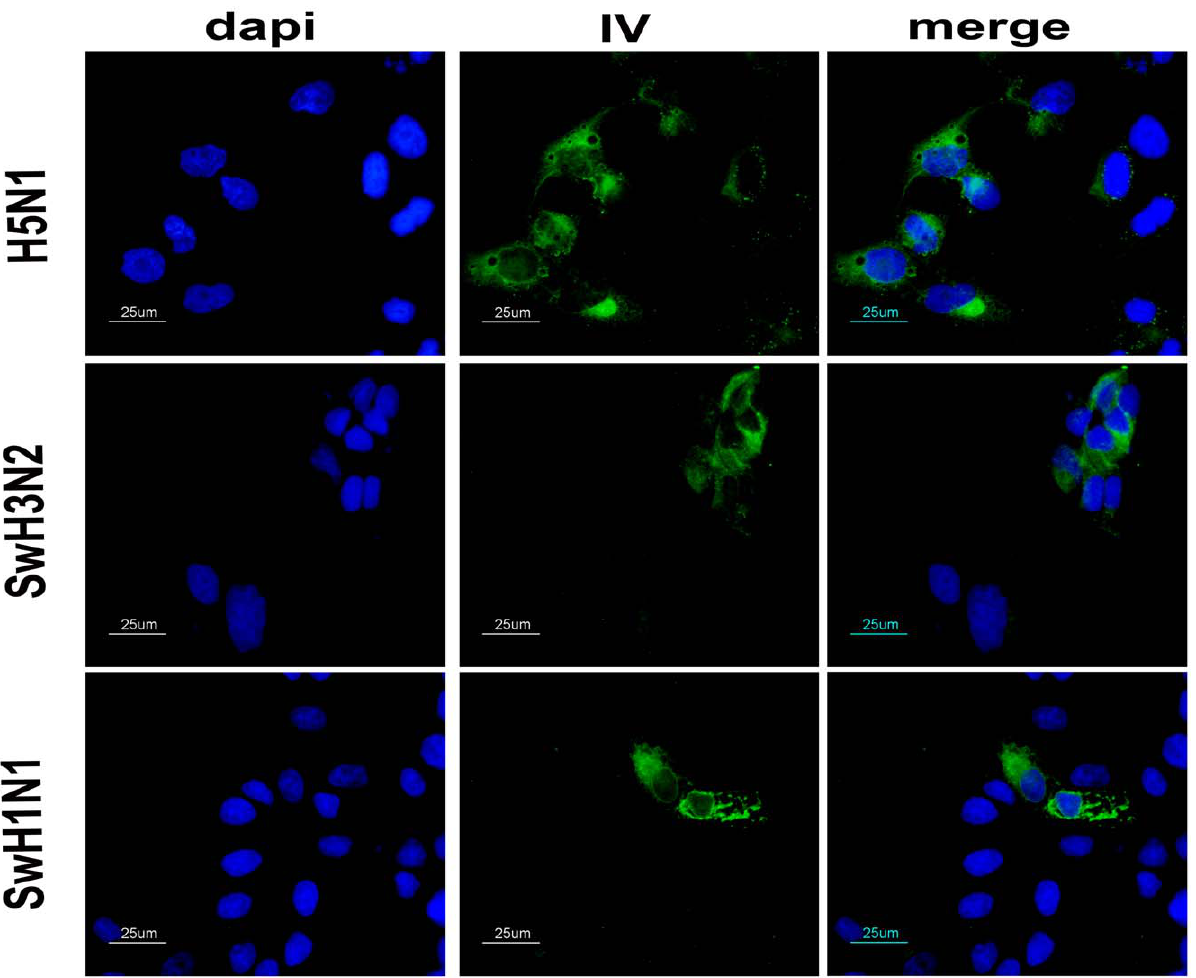
Figure 6. VIN1-sera recognize distinct viral subtypes. Indirect immunofluorescence of either H5N1, SwH3N2 or SwH1N1-infected MDCKs cells at 16 hpi using as primary antibody the serum from one pig (representative of the group), immunized three times with VIN1